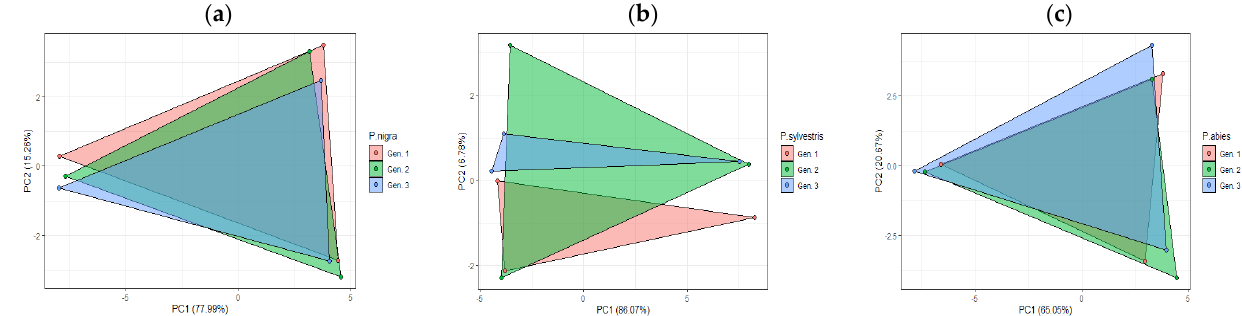
Figure 5. PCA score plot performed on the BVOCs content in the examined genotypes of the examined species: ( a ) Austrian pine; ( b ) Scots pine, ( c ) Spruce.